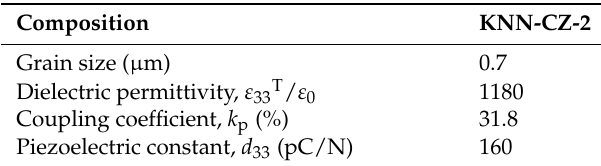
Table 2. Piezoelectric properties of KNN ‐ CZ ‐ 2 single ‐ layer disk sample (measured temperature: 25 °C).